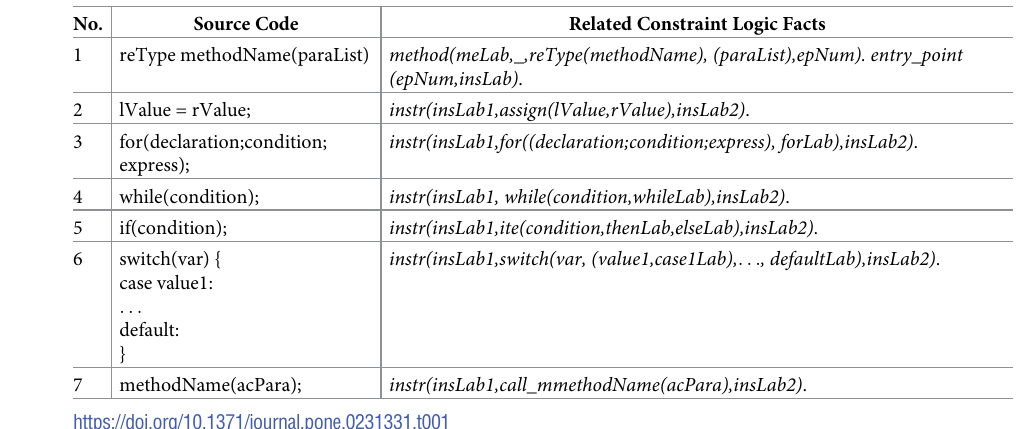
Table 1. Some definitions of constraint logic